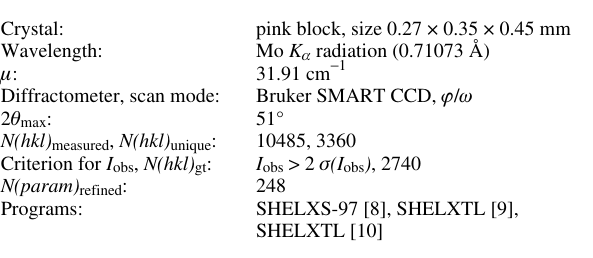
Table 1. Data collection and handling.